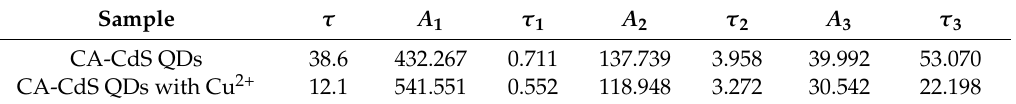
Figure 7. UV–vis spectra ( a ) and fluorescence lifetime decays ( b ) of CA-CdS QDs with different Cu 2+ concentration. Table 1. The fitted values of the fluorescence lifetime decay